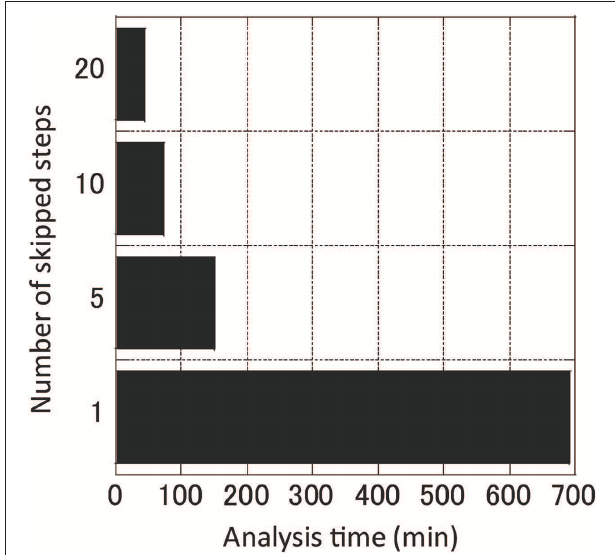
FIGURE 6 | Computational analysis time for four numbers of skipped